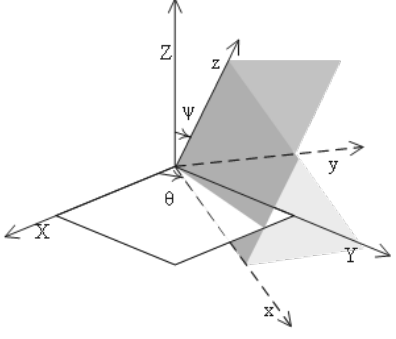
Figure 7. Relation diagram of the coordinate system when z and u